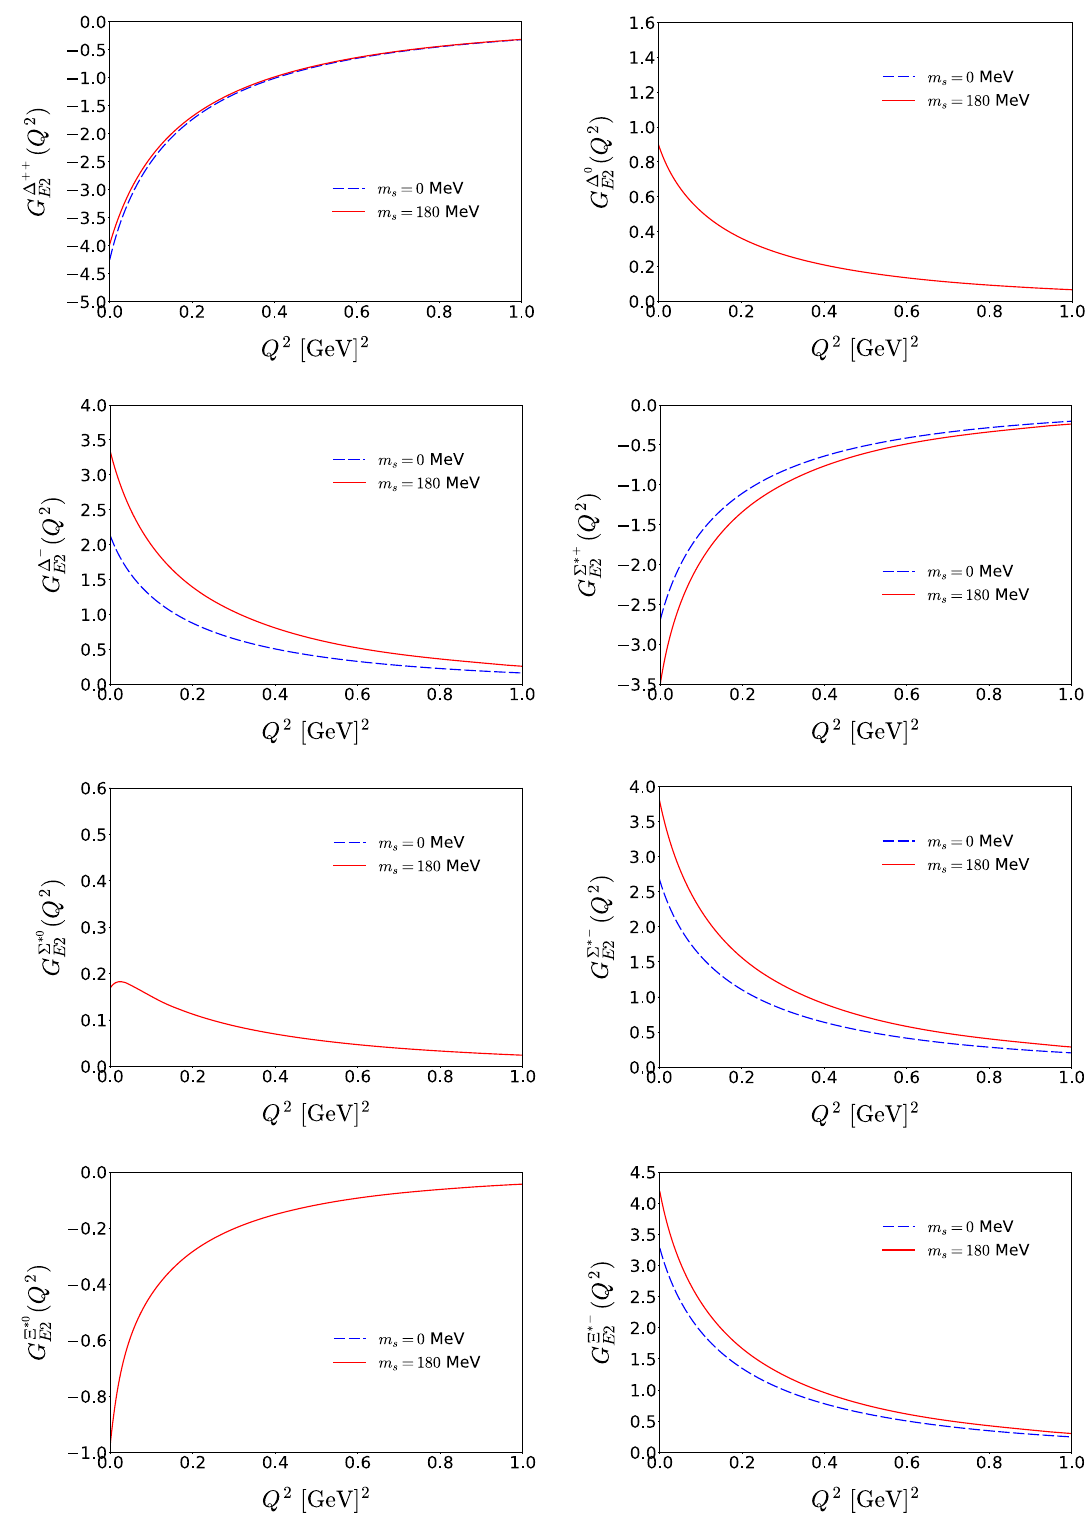
Fig. 12 Effects of the explicit flavor SU(3) symmetry breaking on the electric quadrupole form factors of the baryon decuplet except for the (cid:2) + and (cid:5) − baryons. Notations are the same as in Fig.